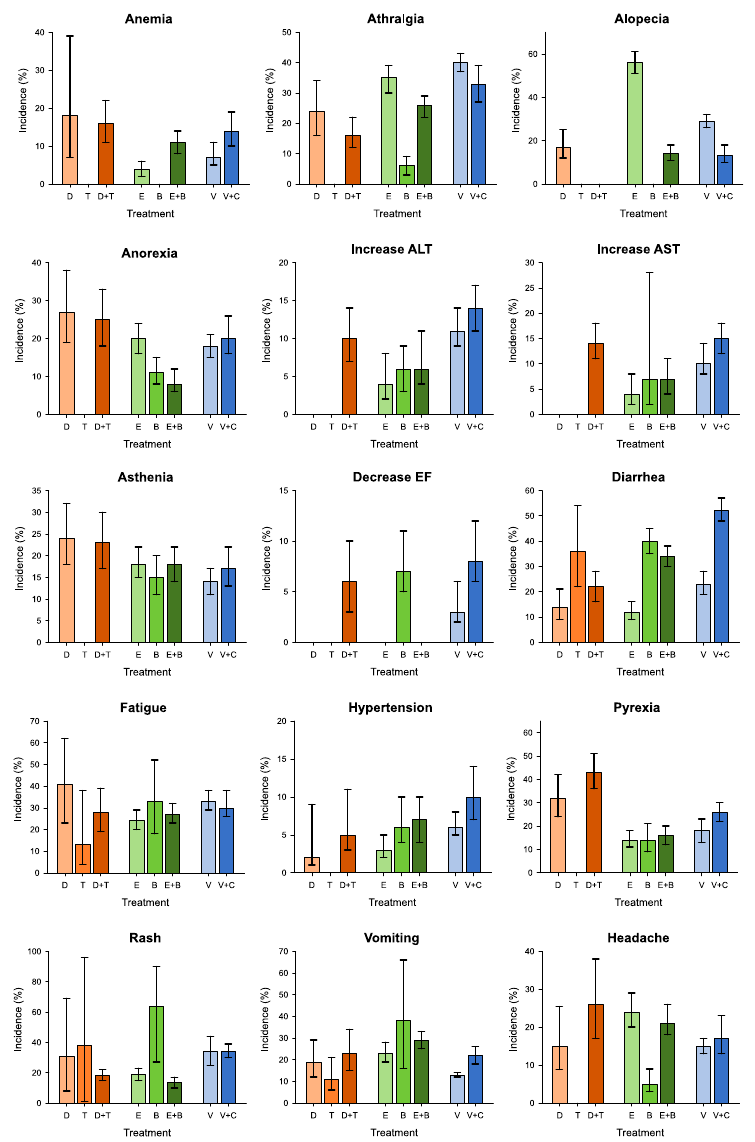
Figure 4. Summary estimates of incidence (%) and corresponding 95% confidence interval of grade 1 – 2 adverse events according to treatment. ALT: alanine aminotransferase; AST: aspartate ami- notransferase; C: Cobimetinib; D: Dabrafenib; E: Encorafenib; EF: ejection fraction; T: Trametinib; V: